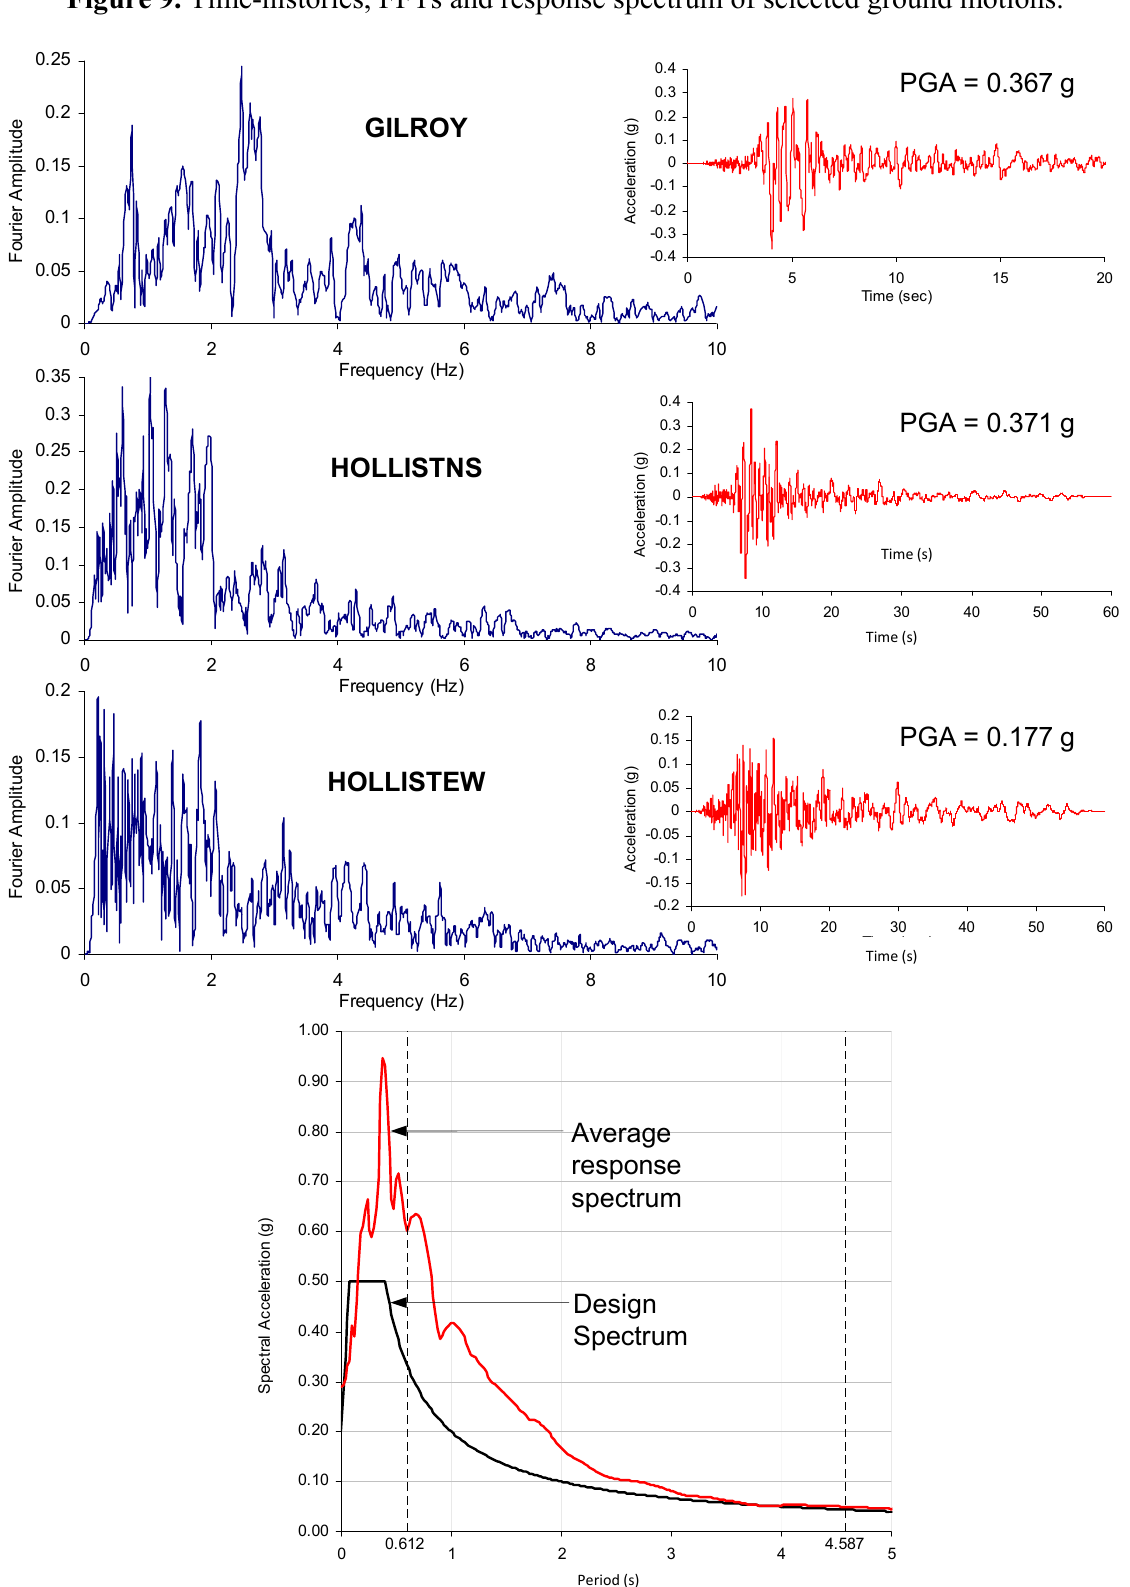
Figure 9. Time-histories, FFTs and response spectrum of selected ground